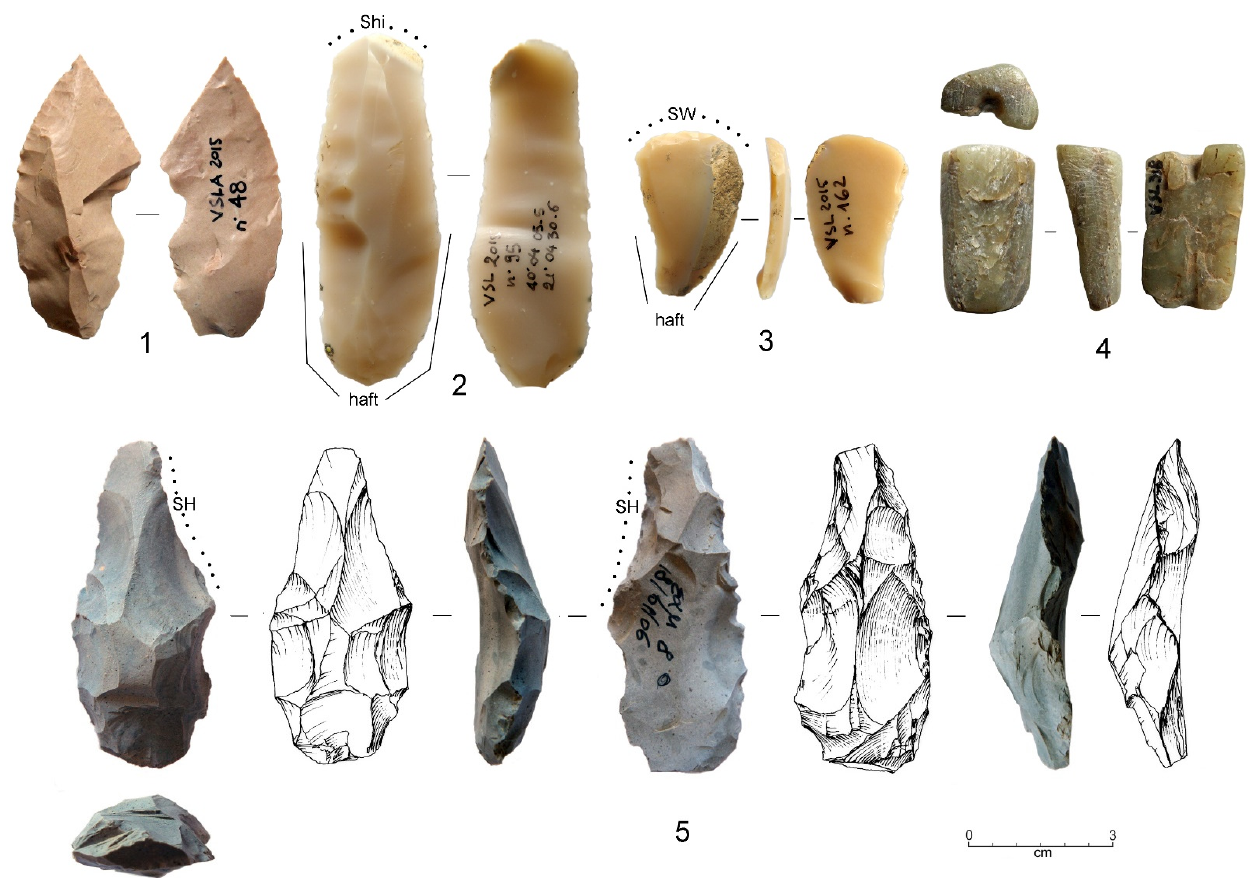
Figure 19. Flat-retouched, unifacial point from Mount Baltoumis Site 3 (VSLA-48, n. 1) made from non-local chert, hafted long-end scraper with scrape hides (Shi) traces of wear made from non-local blonde flint (VSL-95, n. 2), hafted long-end scraper with scrape wood (SW) traces of wear made from non-local blonde flint (VSL-162, n. 3), cylindrical soapstone bead with unfinished, bidirectional perforations, broken, during manufacture, from Mount Baltoumis Site 1 (VSL-318, n. 4), and bifacial artefact with scrape hard (SH) wear traces from Sam-8 (n. 5) (photographs by E. Starnini). Site VSL 2 is located ca. 350 m south-east of Site 1, close to a small pond which attracts grazing flocks for their daily watering (Figure 10 top, n. 2; Figure 15 bottom). The assem- blage was collected from a surface of ca. 1500 square metres. It consists of Middle Palaeo- lithic and Holocene artefacts exhumed by erosion due to pastoral land